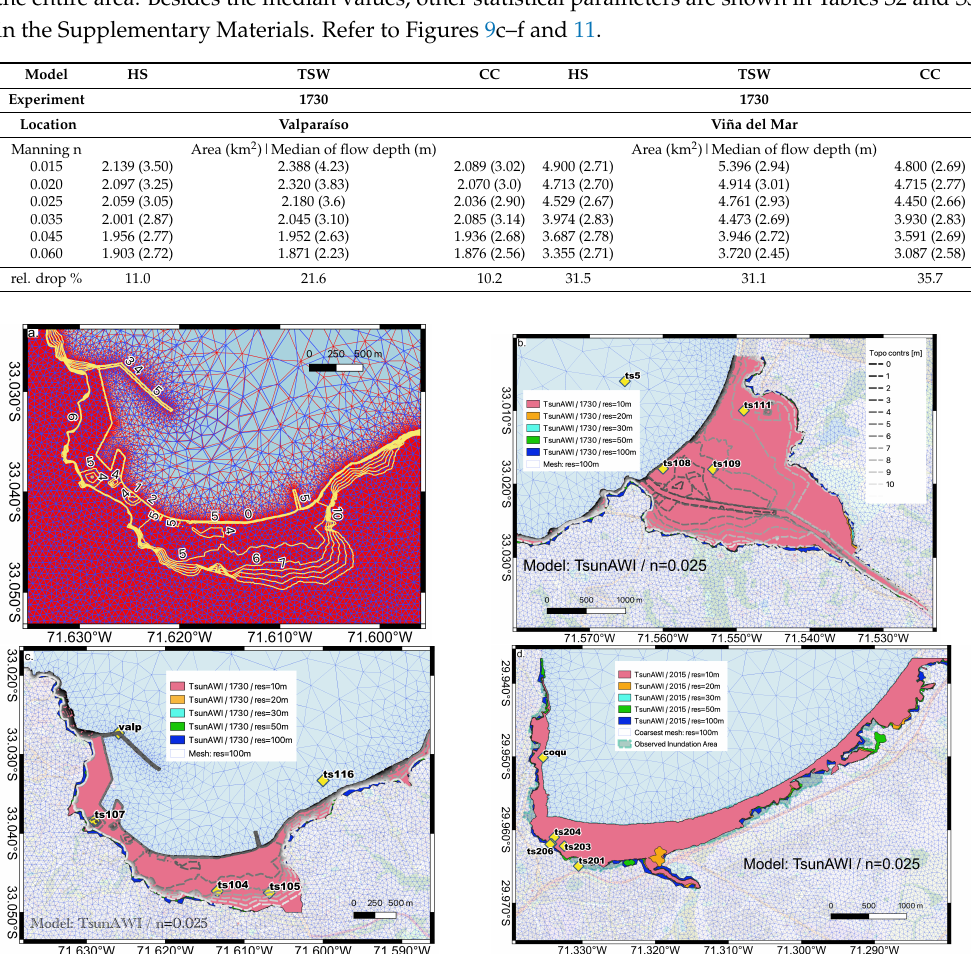
Figure 13. Comparison of the inundation dependency on bathymetry. ( a ). Coarsest mesh (shown in blue) and finest triangulation (shown in red) in the Valparaíso area. ( b ). Inundation area in Viña del Mar in all meshes for Experiment 1730 and a Manning value of n = 0.025, calculated with TsunAWI. ( c ). Inundation area in Valparaíso in all meshes for Experiment 1730 and a Manning value of n = 0.025, calculated with TsunAWI. ( d ). Inundation area in Coquimbo in all meshes for Experiment 1730 and a Manning value of n = 0.025, calculated with TsunAWI. Yellow diamonds show the tide and inland gauges. Basemap: © OpenStreetMap